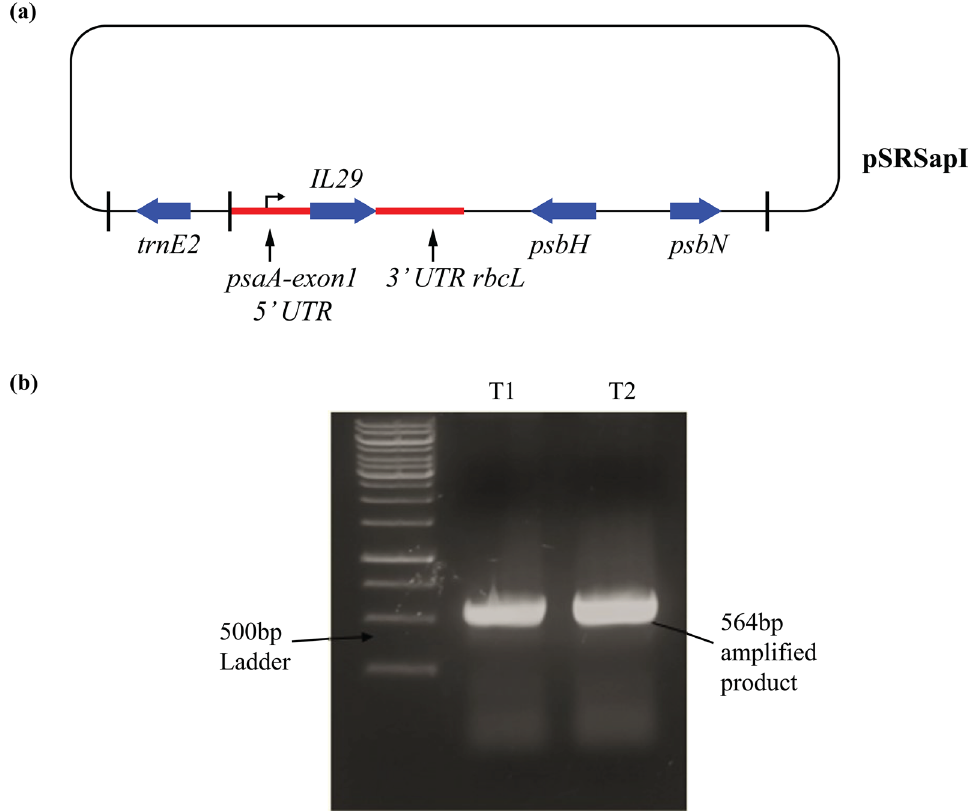
Fig. 1 Generation and confirmation of IL29 transformants. a The pSRSapI- IL29 plasmid contains IL29 under the control of the psaA exon-1 promoter/5 ′ UTR and rbcL 3 ′ UTR. This construct comprises psbH mutated in the TN72 strain of Chlamydomonas reinhardtii. b PCR confirmation of IL29 integration in pSRSapI expression vector through gene-specific primers. Transformants yield the 564 bp